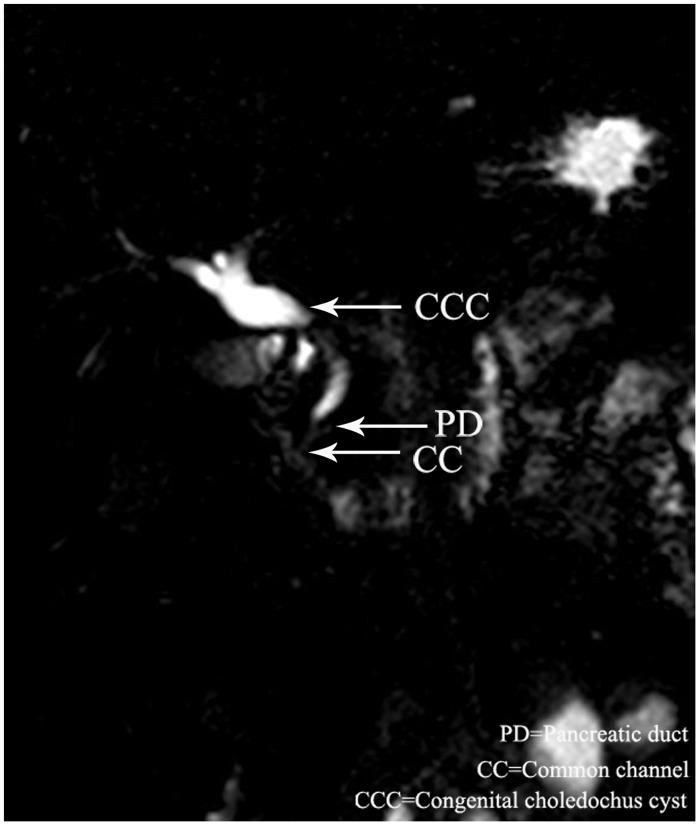
A 2-year old male with PBM, MRCP showed the fusiformis dilataion of the cyst.